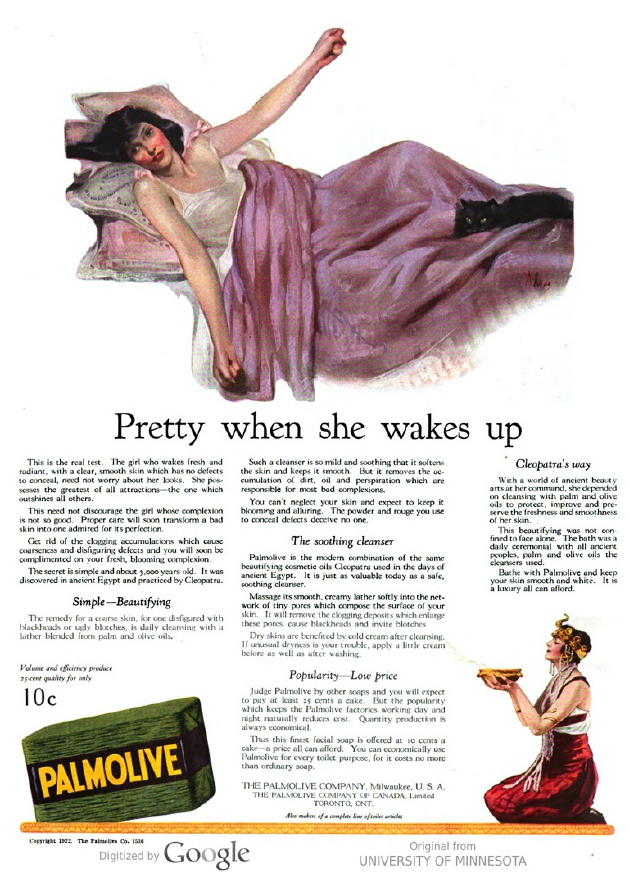
Figure 7. Palmolive Advertisement, Vogue , April 1922, vol. 59, no. 7–12, p. 81. (Courtesy of HathiTrust). Overall, we see that, through this imagery, Cleopatra embodies a white beauty ideal imbued with modernity and feminine power. The question of Cleopatra’s race is what allowed Orientalist depictions of her to be appropriated into whiteness; in an American context, an “Oriental” queen translated into a white aspirational figure of modernity. 13 In other words, depictions of Cleopatra transformed racial otherness into white feminine power. For new women, Cleopatra’s independence and power (linked with her beauty) underscored her desirability. Further, her deployment by soap advertisers also suggests a material enactment by white women to maintain their whiteness through the daily ritual of cleansing to restore purity.